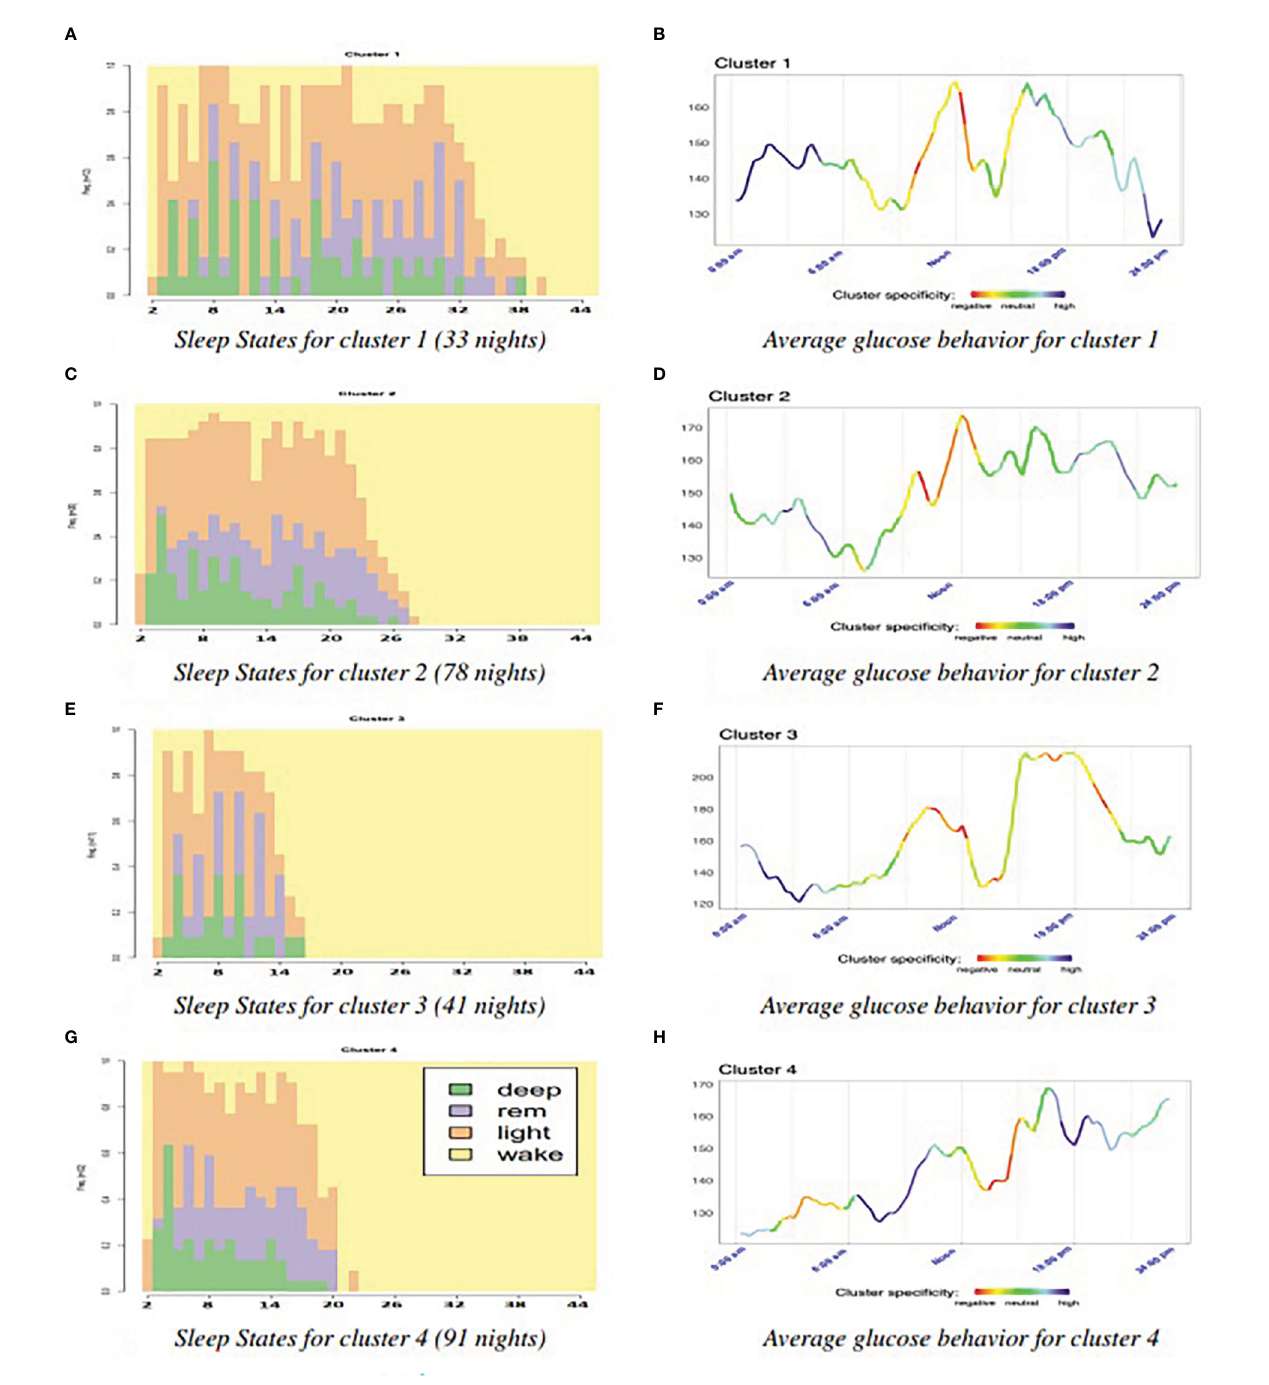
FIGURE 3 Analysis of speci fi c patterns for each cluster. (A) Sleep States for cluster 1 (33 nights) (B) Average glucose behavior for cluster 1. (C) Sleep States for cluster 2 (78 nights) (D) Average glucose behavior for cluster 2. (E) Sleep States for cluster 3 (41 nights) (F) Average glucose behavior for cluster 3. (G) Sleep States for cluster 4 (91 nights) (H) Average glucose behavior for cluster